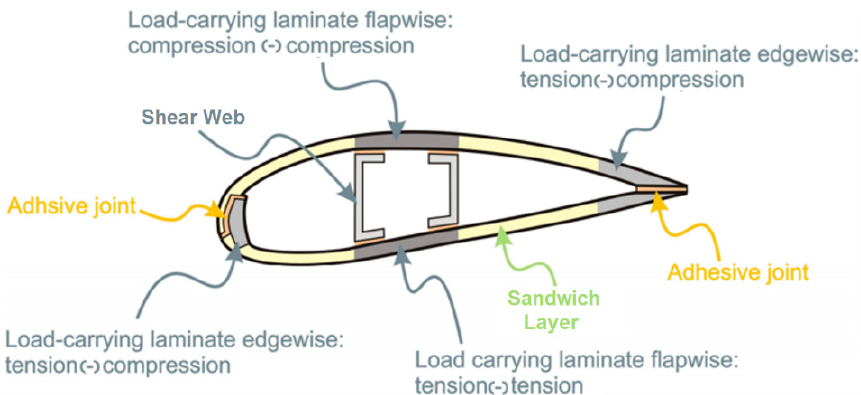
Figure 1. WTB schematic cross-section and structure, inspired by [14].